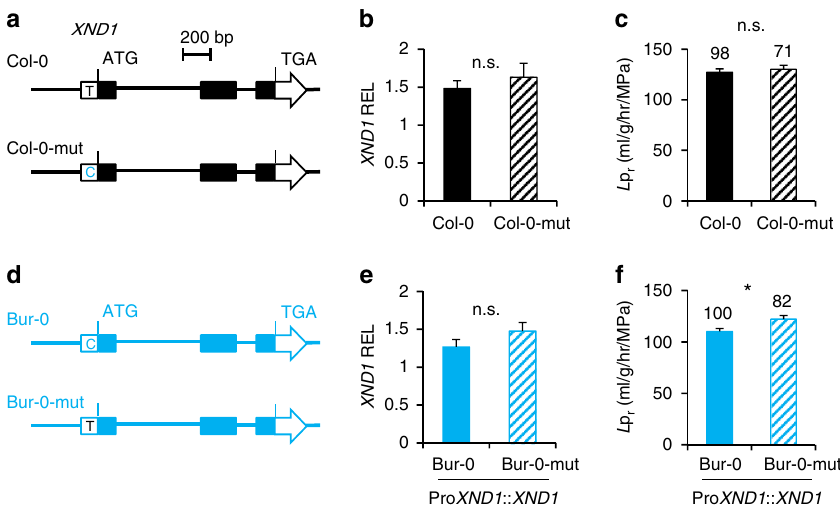
Fig. 3 SNP UTR of XND1 contributes to L p r variation. Transgenic complementation of xnd1 – 5 with Col-0 or Bur-0 allelic forms of XND1 , either wild-type or with a site-directed mutation at SNP UTR . a , d Schematic representation of investigated XND1 allelic forms. Col-0 and Bur-0 indicate the wild-type forms while Col-0-mut and Bur-0-mut indicate the corresponding point mutated forms. b , e Transcript abundance of XND1 in xnd1 – 5 homozygous transgenic lines expressing the Col-0, Col-0-mut, Bur-0, or Bur-0-mut forms of XND1 . Three to fi ve independent transgenic lines (two biological replicates for each) were studied for each form. Mean values ± SE ( n = 18 – 30) were normalized to transcript abundance in Col-0. c , f L p r of the transgenic lines described above. Three to fi ve independent transgenic lines were phenotyped for each form. Mean values ± SE are shown with total number of plants indicated on the top. Student ’ s t test ( * P < 0.05) was used to assess the statistical signi fi cance of the data (n.s. = not signi fi cant). XND1 expression and L p r data in individual transgenic lines are shown in Supplementary Figure 7